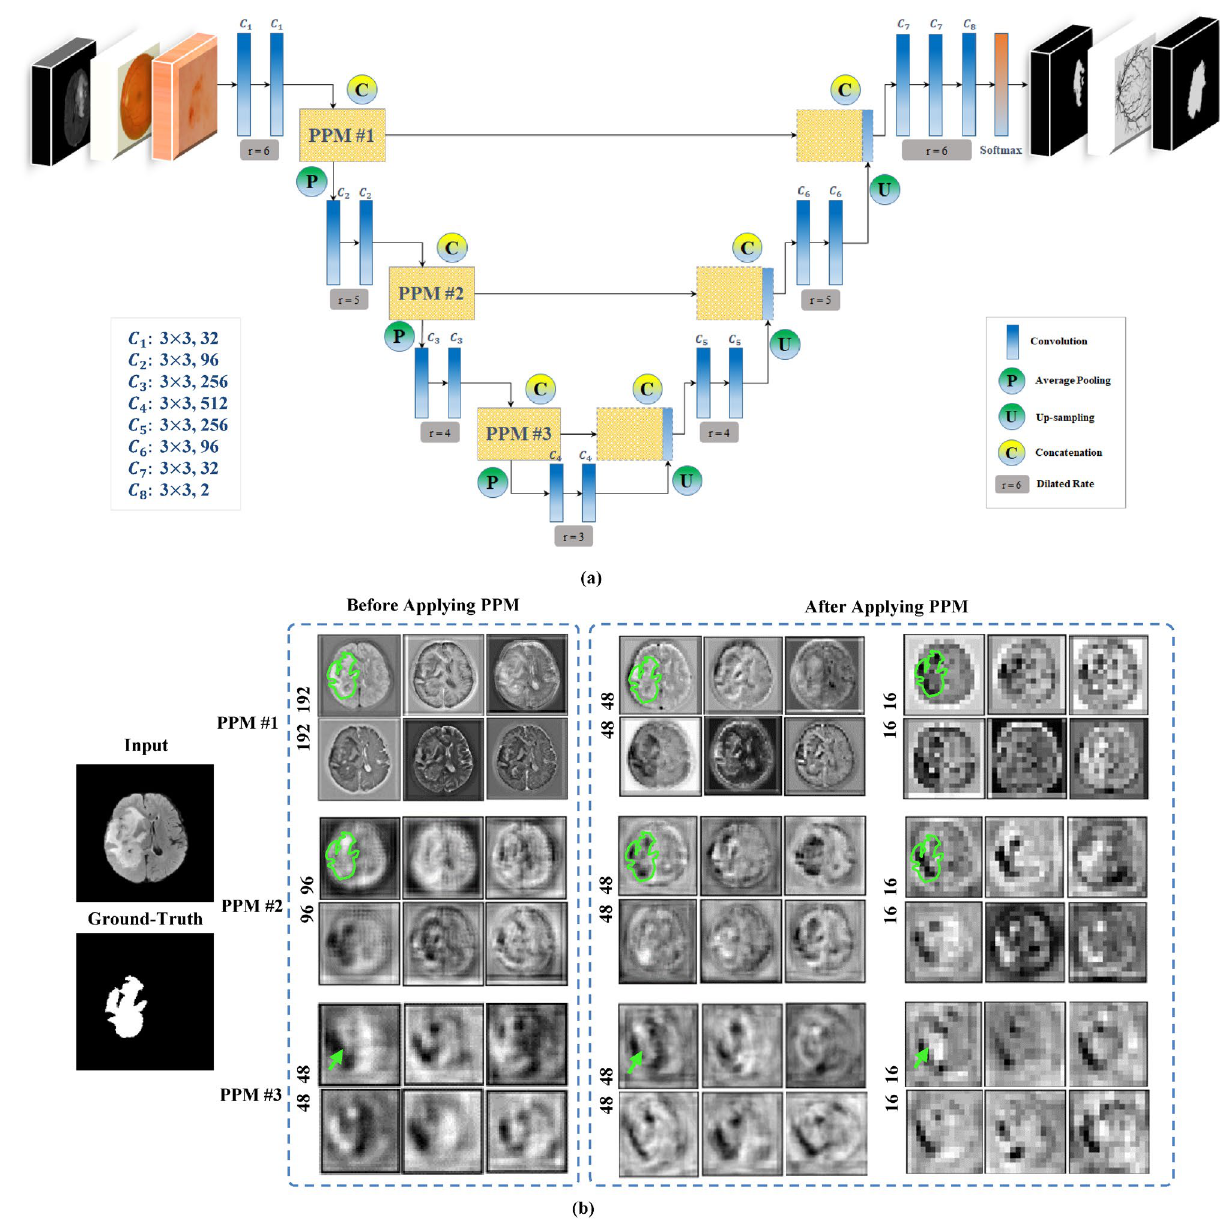
Figure 3. ( a ) The architecture of the proposed CMM-Net segmentation method. Details of the filter sizes and the number of feature maps are illustrated in the bottom left corner of ( a ). ( b ) Visualization of example feature maps before and after applying the PPM at different encoder levels. The larger two scales of each PPM with sizes of 48 × 48 and 16 × 16 are presented since they contain intelligible